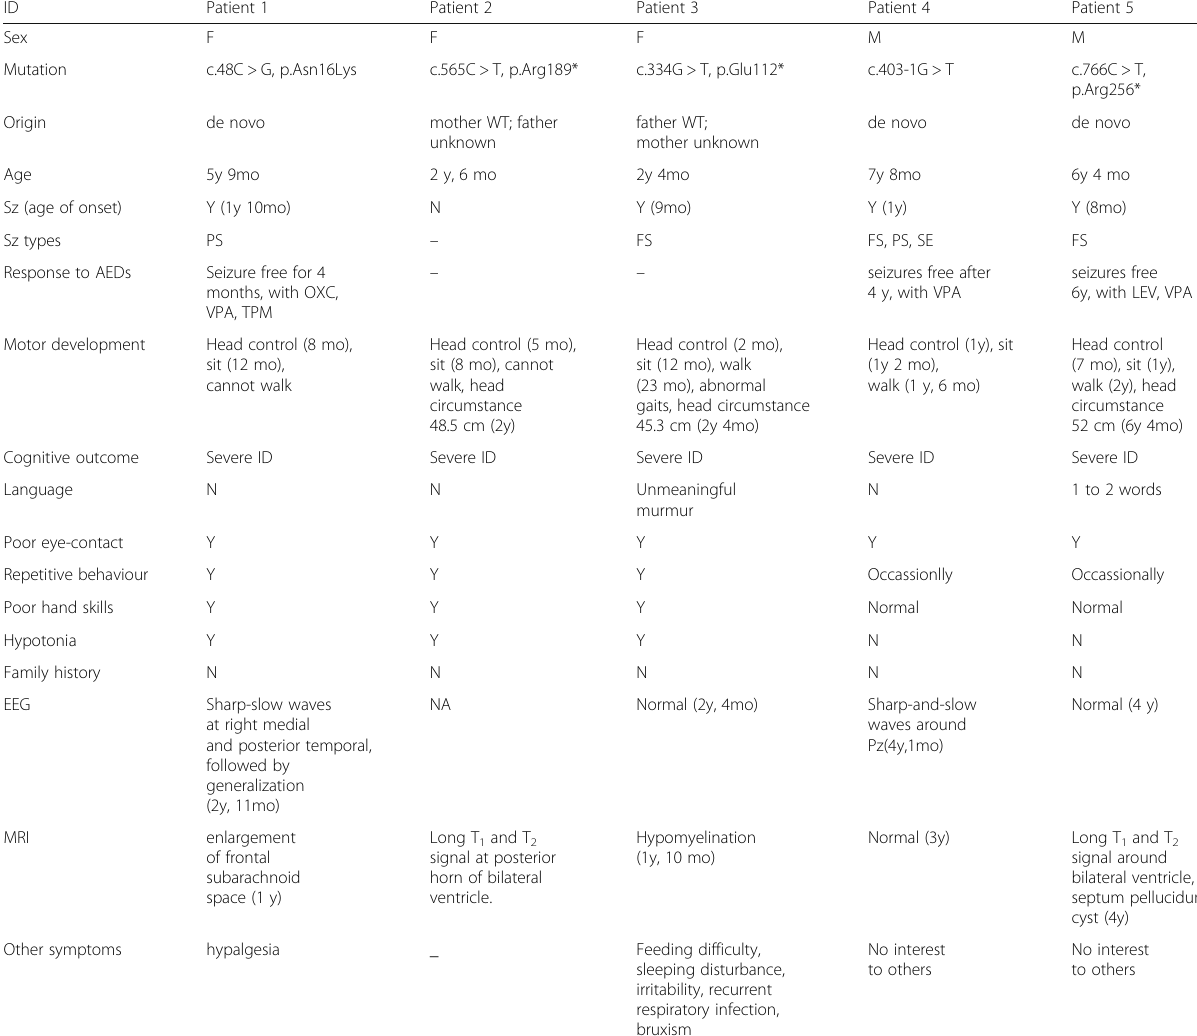
Table 1 Clinical information of patients with MEF2C (NM_001193350)